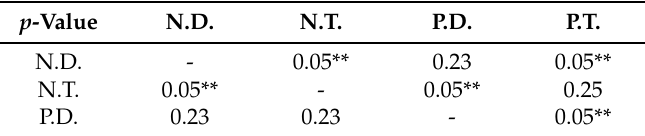
Table 2. The Wilcoxon signed-rank in comparing the paired set of top 100 words in each category of hotel reviews.